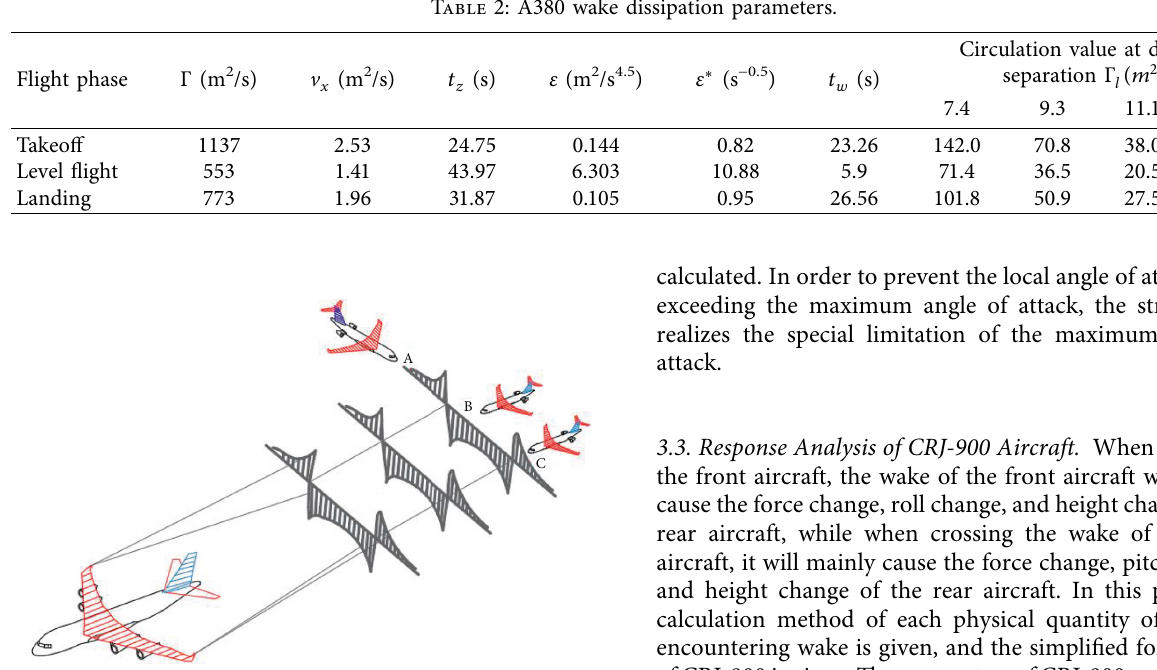
Figure 3: Schematic diagram of different modes of wake vortex field before aircraft